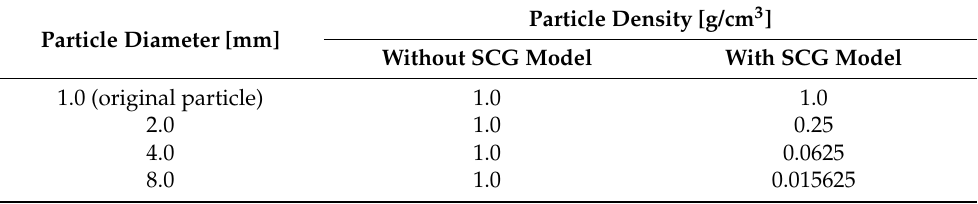
Figure 1. Initial positions of original and CG particles and schematic diagram of uniform flow field. The original particle and three CG particles are positioned for their centers to be lined up on the same straight line. Table 1 shows the simulation conditions of the particles. The densities of the CG particles are calculated by Equation (7). The fluid density and viscosity are set to 1.2 kg/m 3 and 1.8 × 10 − 5 Pa · s, respectively. Table 1. Simulation conditions (uniform flow